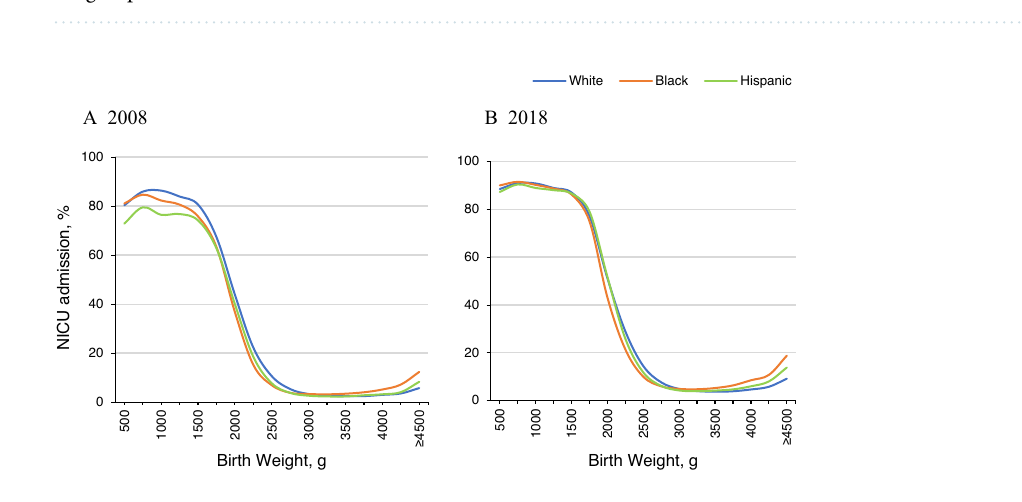
Figure 2. Temporal trends for crude NICU admission rates by race/ethnicity for 2008–2018 all births and subgroups.